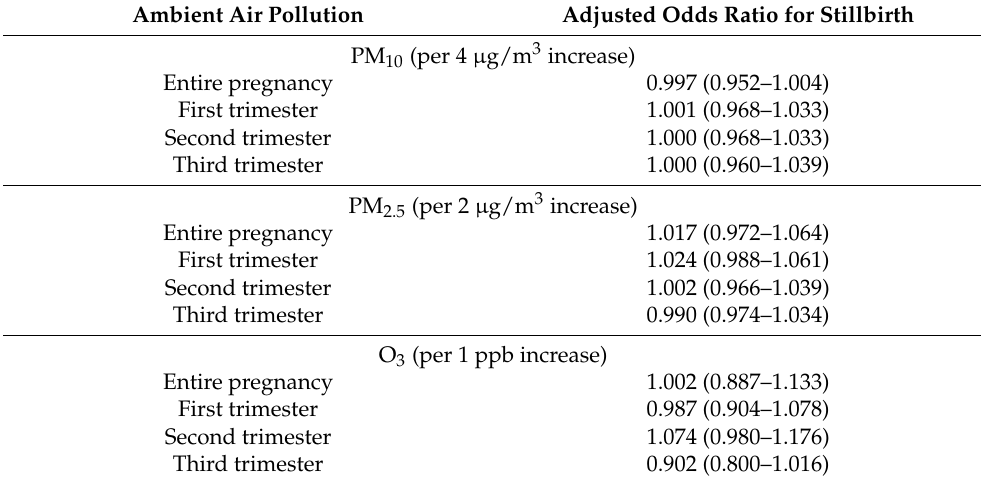
Table 3. Adjusted 1 odds ratios of stillbirth associated with ambient air pollution exposure, Sydney, Australia